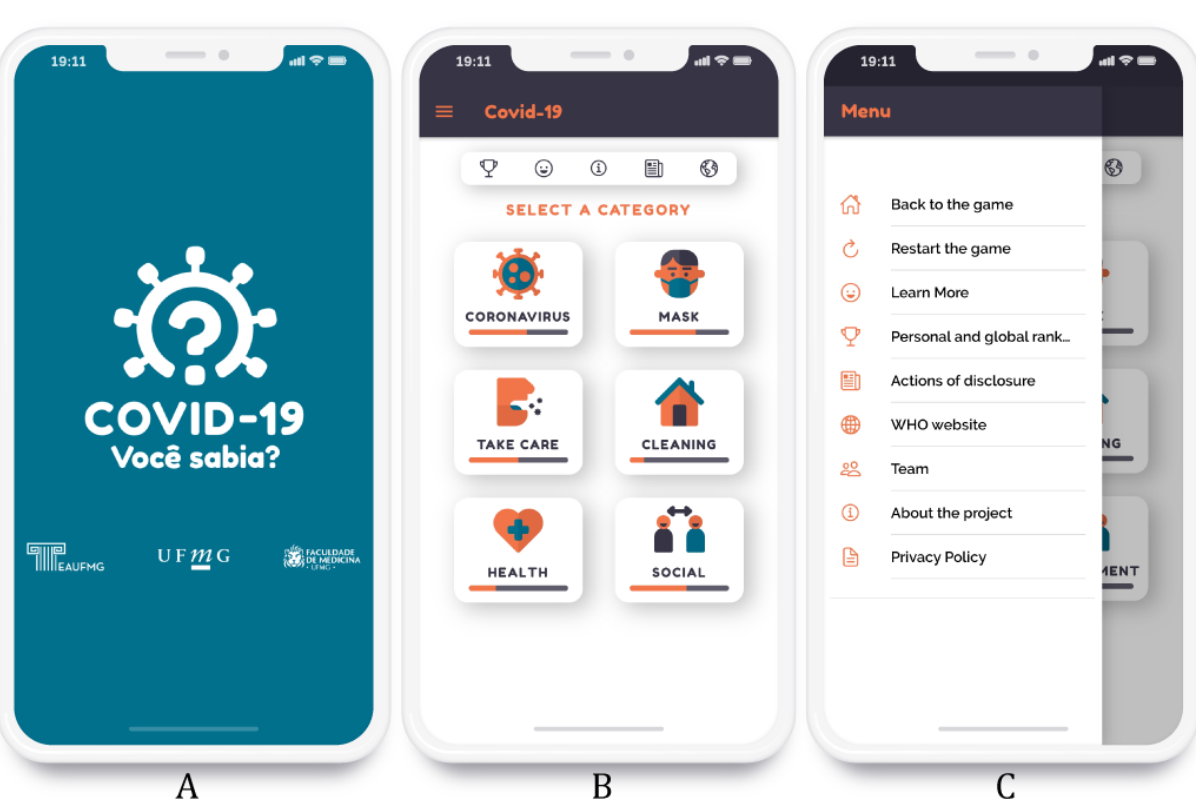
Figure 2. Interfaces of the initial screens of the game: Splash (A), Home (B), and Menu